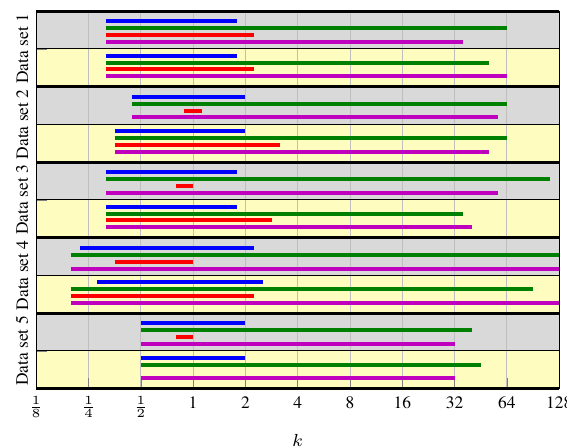
Figure 6: The pull-in range for varying values of m for all data sets and experiments. Gray background corresponds to the FULL experiment, yellow to the STABLE experiment. In general, the undamped GM method (blue) converges when the initial focal length is roughly within a factor of 2 of the true for all experi- ments and data sets. The damped GNA (green) and LMP (purple) methods converge in less than 100 iterations for m = 1 / 2 up to at least m = 32 . The damped LM (red) behaviour is more com- plex and is discussed in the text. Data set 4 has the widest pull-in range, data set 5 the